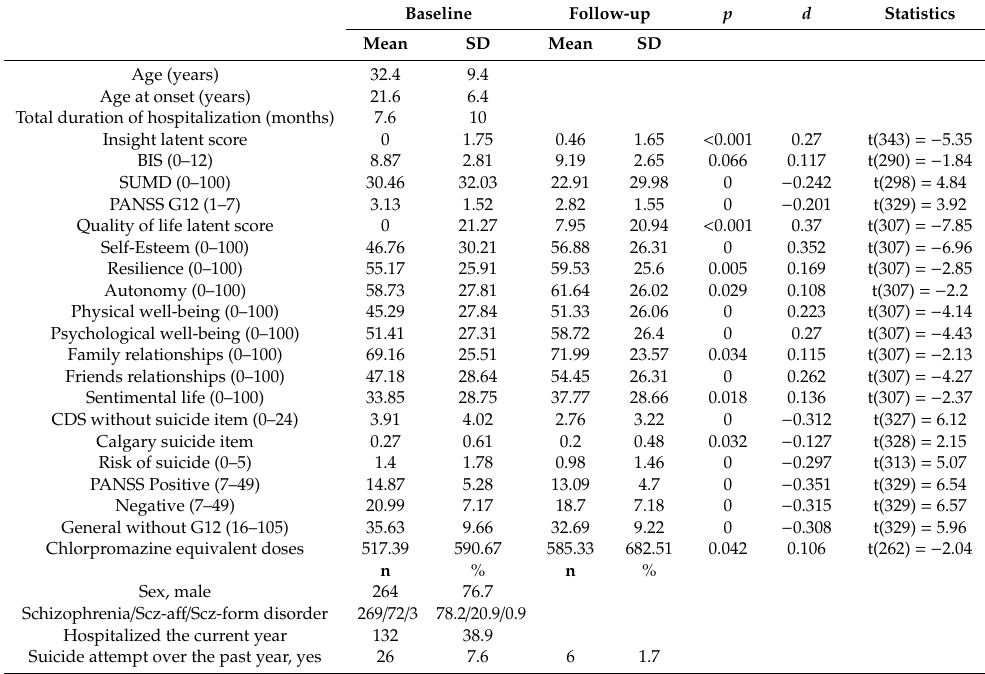
Table 1. Socio-demographic and clinical characteristics of the final sample and evolution of the variable of interest between inclusion and follow-up (BIS: Birchwood Insight Scale; SUMD: Scale to assess Unawareness of Mental Disorder; PANSS: Positive And Negative Syndrome Scale; S-QoL: Schizophrenia Quality of Life; CDS: Calgary Depression Scale; Scz-a ff : schizo-a ff ective; Scz-form: schizophreniform; n: